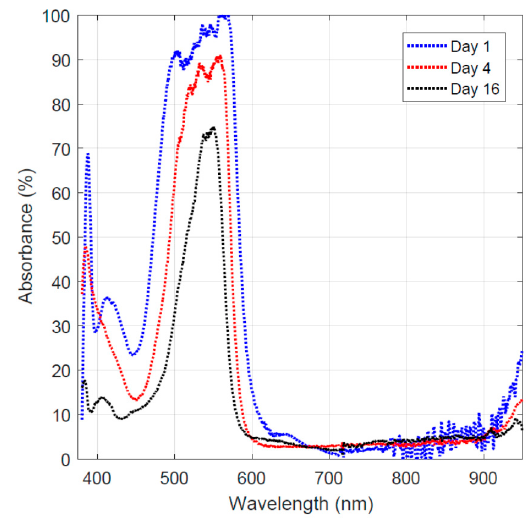
Figure 4. Light absorption of the remaining dye on different days.